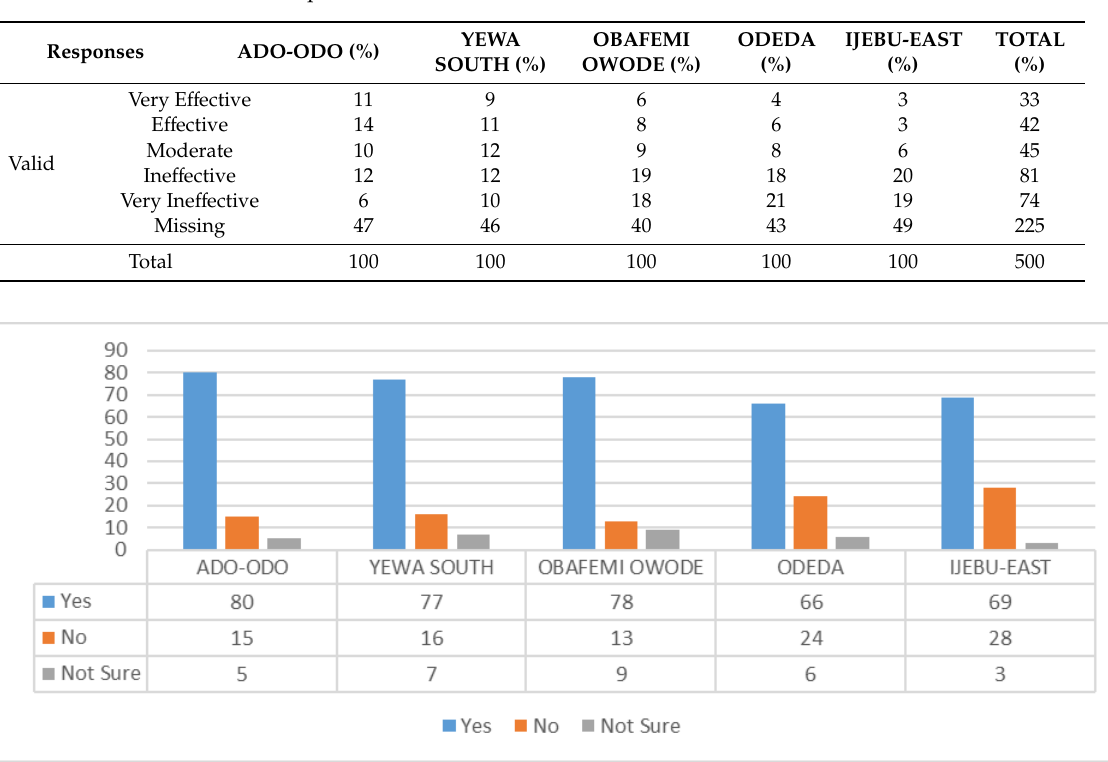
Table 14. Responses on the e ff ectiveness of the environmental task forces.